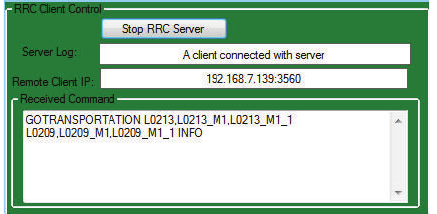
Figure 15: Received transportation order on MFS GUI.